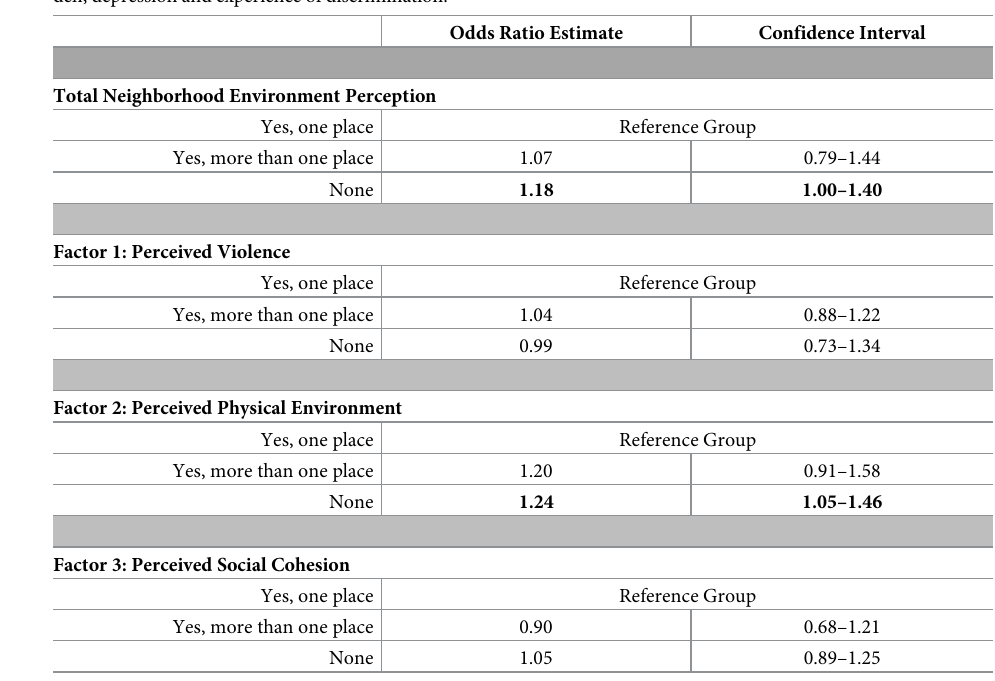
Table 3. Odds ratios of reporting a usual source of care as related to neighborhood environment perception. Ref- erence group reports having one usual source of care. Final model adjusted for age, sex, race/ethnicity, marital